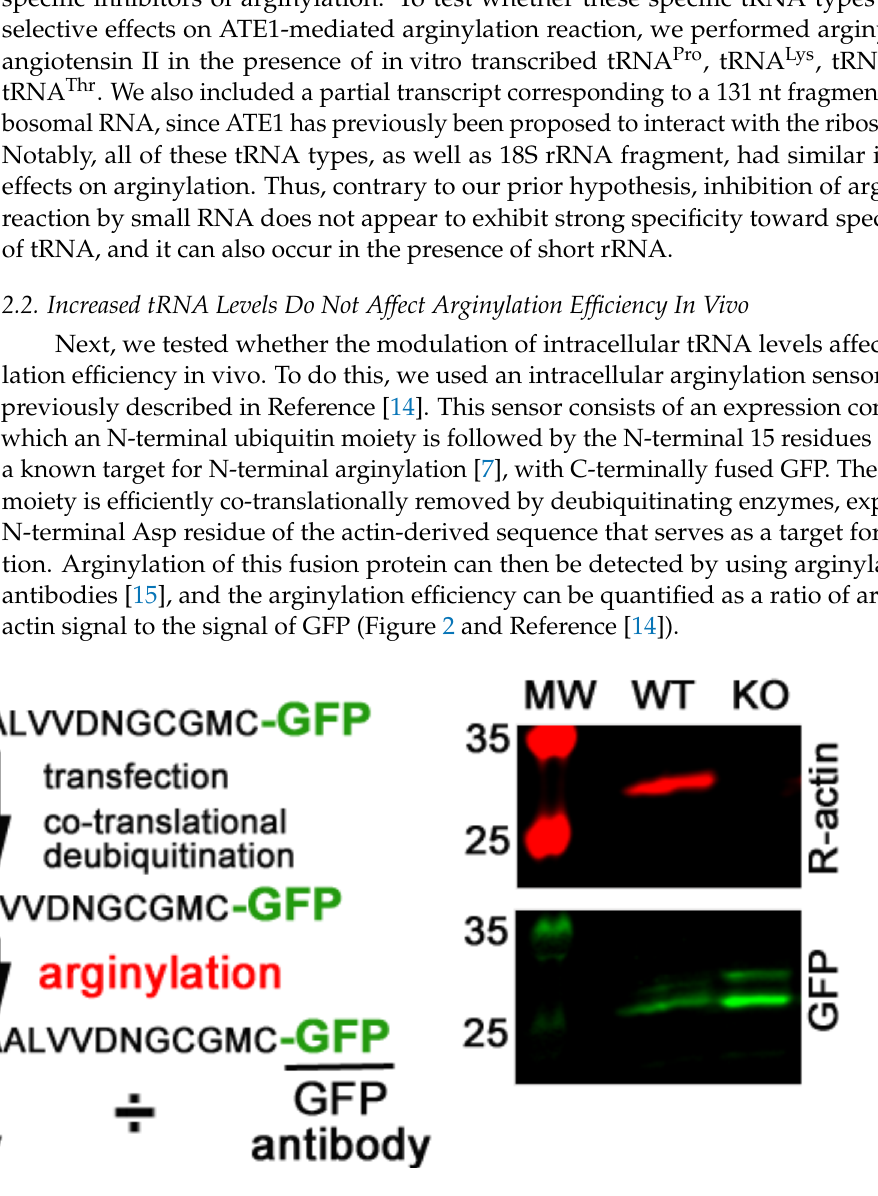
Figure 2. Arginylation sensor for detection of intracellular arginylation. Left, diagram; right, repre- sentative Western blot of the arginylation sensor transfected into wild-type (WT) and Ate1 knockout (KO) mouse embryonic fibroblasts and visualized with antibodies to arginylated β actin (R-actin) and GFP. Ratio of the R-actin:GFP signal was used in the intracellular assays described